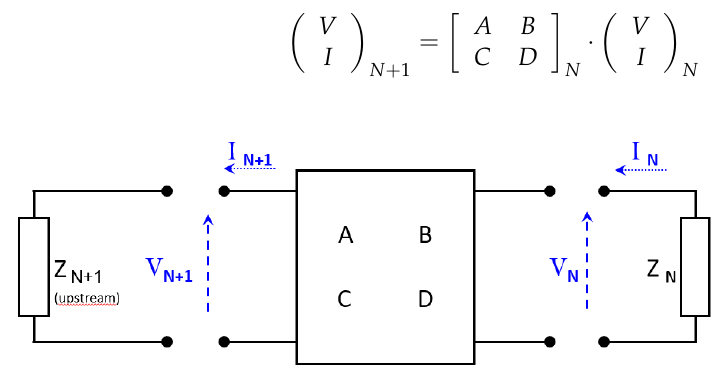
Figure 8. Description of Chain (or [ABCD] Transfer)